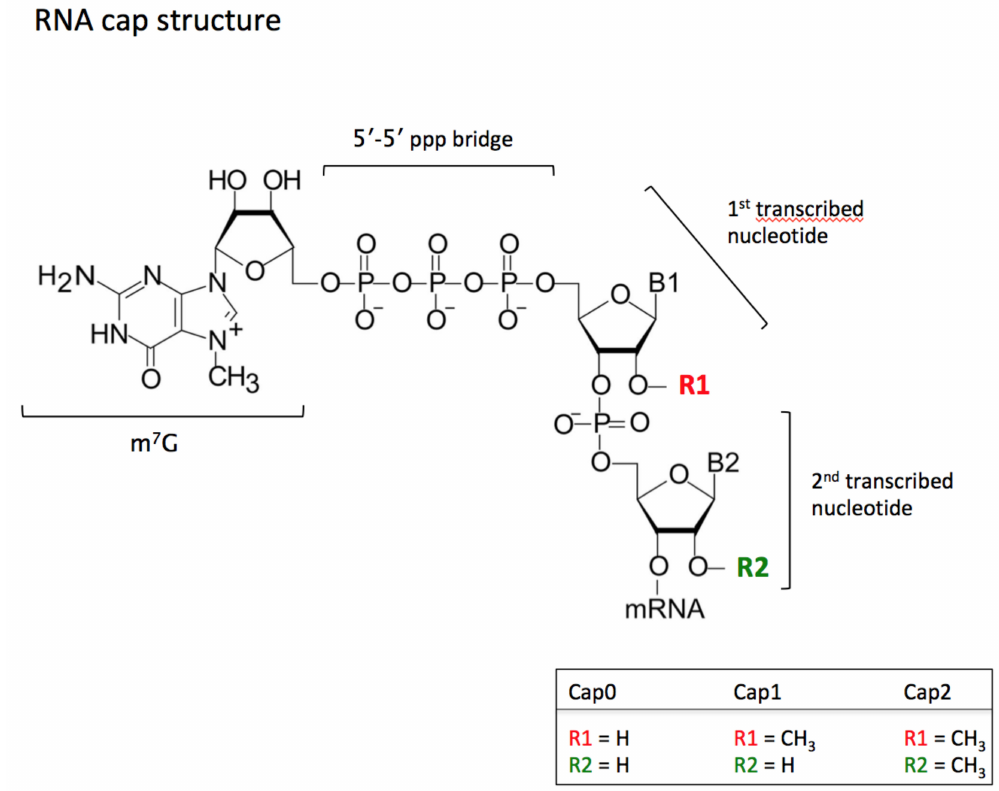
Figure 3. RNA cap structure: The cap0 structure consists of a guanosine residue, methylated in the N-7 position, which is bound to the terminal 5 (cid:48) -end nucleotide of the mRNA with a 5 (cid:48) -5 (cid:48) triphosphate bridge. Subsequent 2 (cid:48) -O-methylation in the ribose of the first, or both the first and the second, transcribed mRNA nucleotides leads to the formation of cap1 or cap2, respectively. This figure has been adapted from Reference